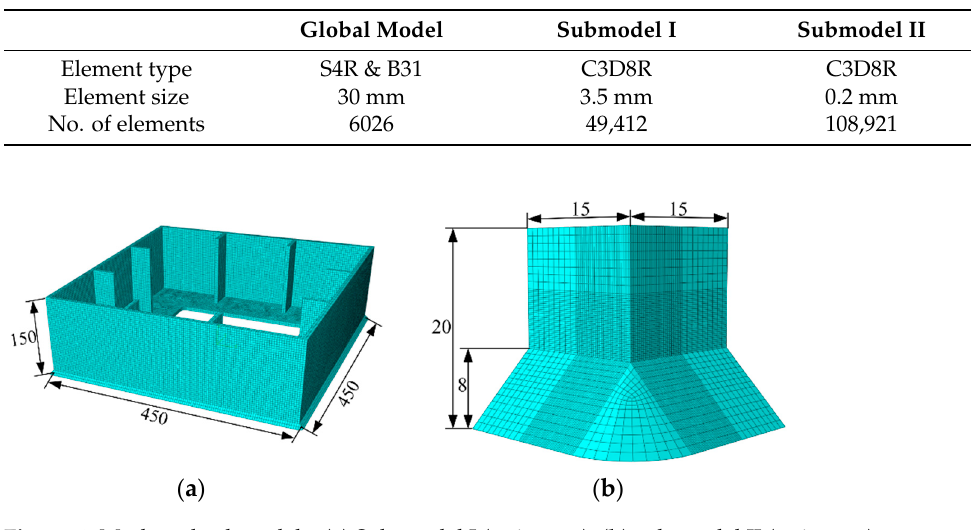
Figure 3. Finite element model separated into submodels. Table 3. Summary of meshing information.